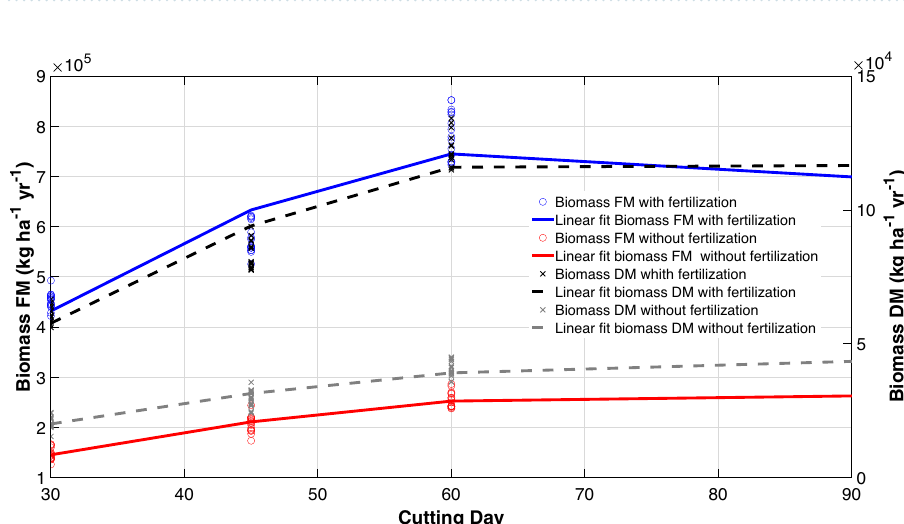
Figure 2. Linear relationship between biomass production of King grass on different cutting days and in systems with and without fertilization. Plots were created in MATLAB R2021a. FM fresh matter, DM dry matter. Lineal regression equations ( C cutting day): Biomass FM with fertilization: − 199.4084 C 2 + 28,382.8977C − 240,005.9343. r 2 = 0.8113, n = 63, P < 0.001. Biomass FM without fertilization = − 53.7566 C 2 + 8406.3371 C − 58,284.7854. r 2 = 0.9069, n = 63, P < 0.001. Biomass DM with fertilization = − 32.0241 C 2 + 4824.9404 C − 58,229.4563. r 2 = 0.8290, n = 63, P < 0.001. Biomass DM without fertilization: = − 8.2090 C 2 + 1374.6121C − 13,776.6985. r 2 = 0.8997, n = 63, P <